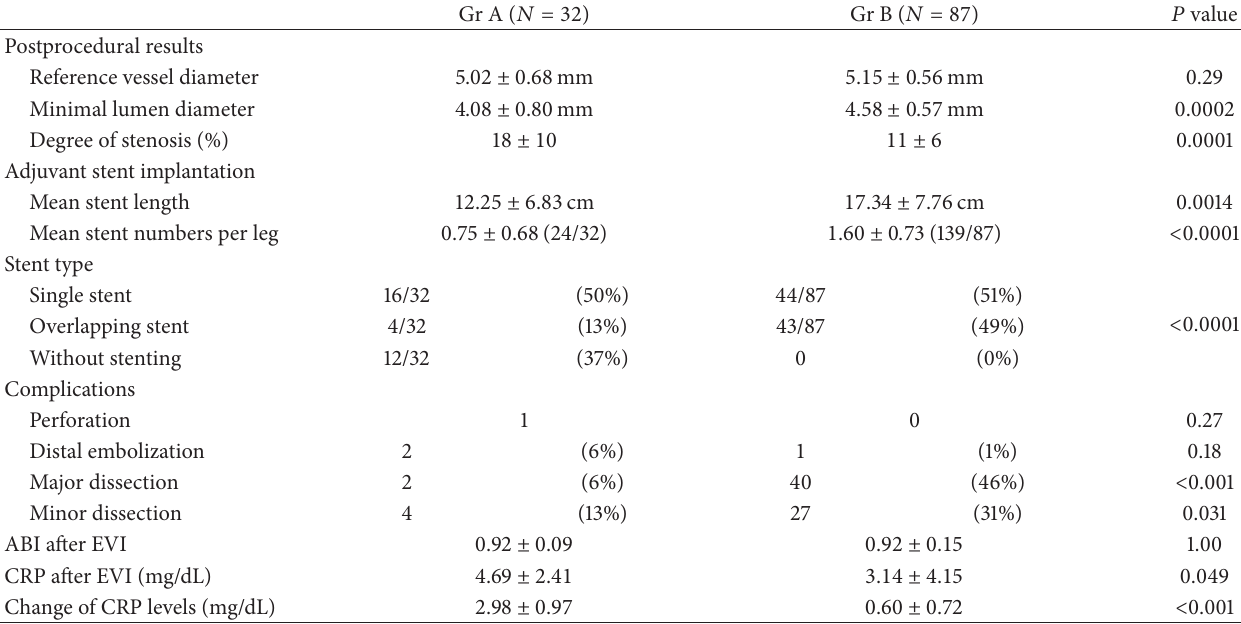
Table 3: Immediate procedural results.